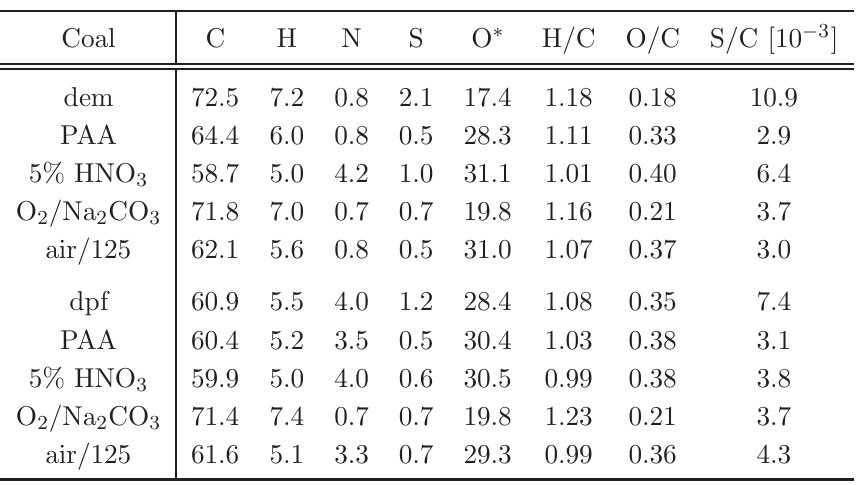
Table 5 Elemental analysis of THF extracts [wt %] and molar ratios of H/C, O/C and S/C.